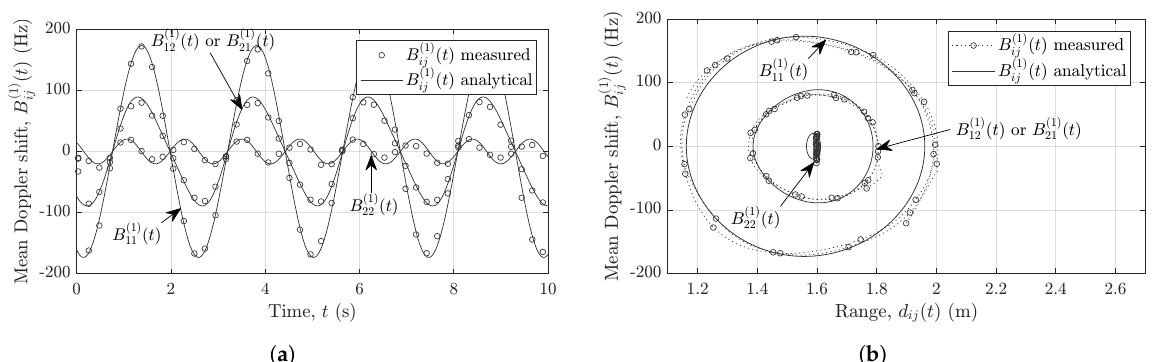
( 1 ) ( t ) vs. time and ( b ) the measured mean Doppler shift B ( 1 ) ij